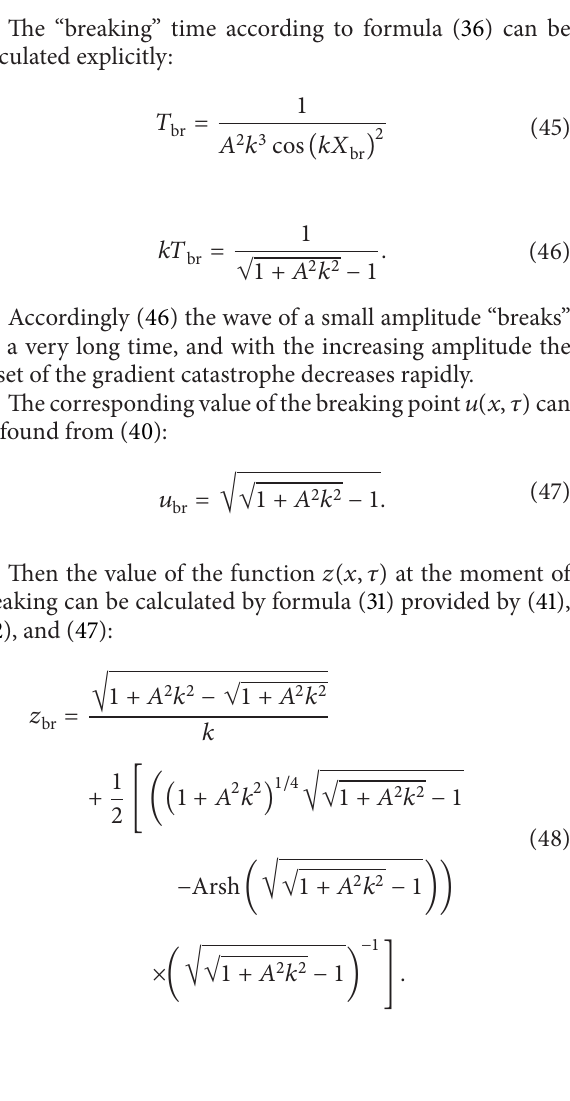
Figure 3: Dependence of the normalized breaking values 𝑍 𝑢 on the value 𝑘𝐴 br